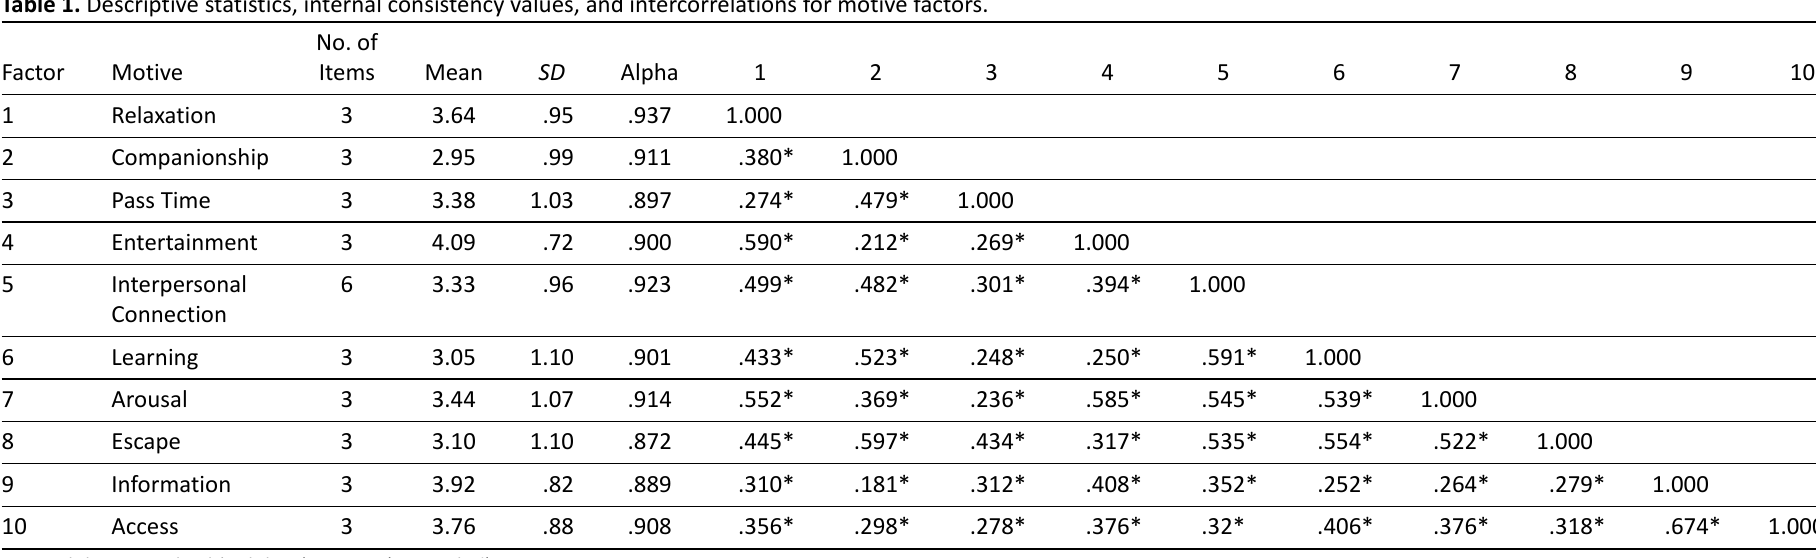
Table 1. Descriptive statistics, internal consistency values, and intercorrelations for motive factors. No.